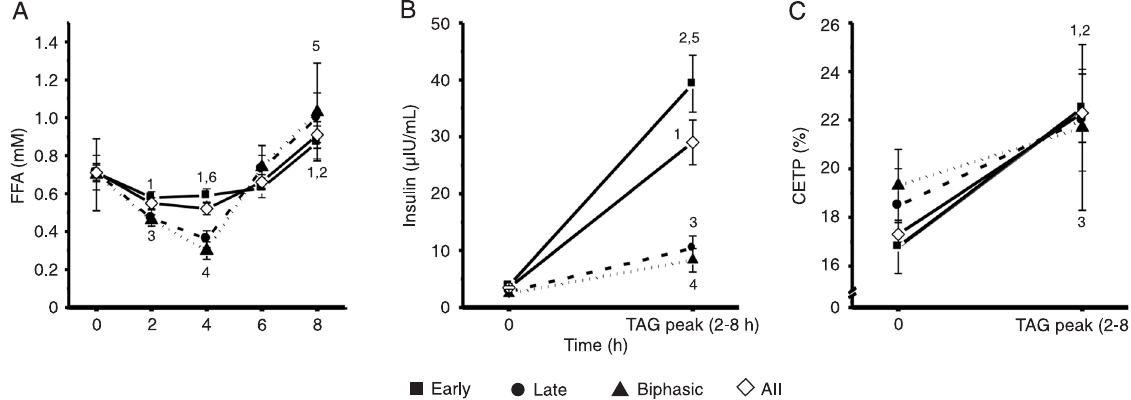
Figure 2. Postalimentary plasma free fatty acids (FFA), insulin and cholesteryl ester transfer protein (CETP) after a standardized meal. Data are reported as means ± SEM. N = minimum to maximum number of subjects with parameters determined. Wilcoxon and ANOVA with post hoc Duncan tests. A , FFA: all individuals [N = 54 subjects in the fasting period (FP), 4th and 8th hours; N = 52 at the 2nd hour and N = 51 at the 6th hour], 1 P ≤ 0.008, FFA decreased from baseline to the 2nd and 4th hours, and increased to the 8th hour; early responders (N = 37 subjects in the FP and at the 4th and 8th hours; N = 35 at 2nd hour and N = 34 at 6th hour), 2 P ≤ 0.045, FFA increased from baseline to the 8th hour; late responders (N = 17, all times), 3 P ≤ 0.04, FFA decreased from baseline to the 2nd hour, 4 P ≤ 0.005 to the 4th hour, and 5 P ≤ 0.012 FFA increased to the 8th hour; early responders: 6 P ≤ 0.00001 at the 4th hour higher than late and biphasic responders (N = 7, all times). B , Insulin: 1 P ≤ 0.00001, 2 P ≤ 0.00001, 3 P ≤ 0.0009, 4 P ≤ 0.018, respectively, in all individuals (N = 47 in FP and N = 45 in TAG peak), early responders (N = 31 in FP and N = 29 in TAG peak), late responders (N = 16 in FP and TAG peak), and biphasic responders (N = 7 in FP and TAG peak), insulin increased from baseline to the 4th hour; early responders: 5 P ≤ 0.00001, higher peak than in late and biphasic responders. C , CETP: in all individuals (N = 54 subjects in FP and N = 48 in TAG peak), early responders (N = 37 in FP and N = 33 in TAG peak) and late responders (N = 17 in FP and N = 15 in TAG peak), CETP increased from baseline to the 4th hour: 1 P ≤ 0.0003, 2 P ≤ 0.002, 3 P ≤ 0.044, respectively (Wilcoxon test). Biphasic (N = 7 subjects in FP and TAG peak): results not significant at 4th